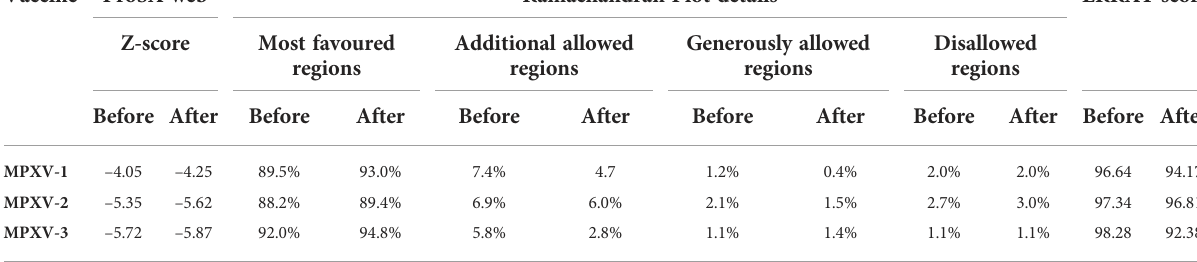
TABLE 5 Validation of the modeled 3D structures of constructed vaccines. Vaccine ProSA-web Ramachandran Plot details ERRAT score Additional allowed